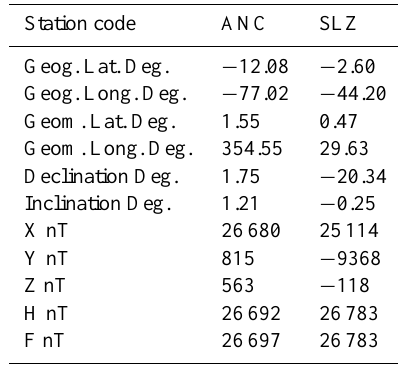
Table 1. Geographic and Geomagnetic parameters of stations: March